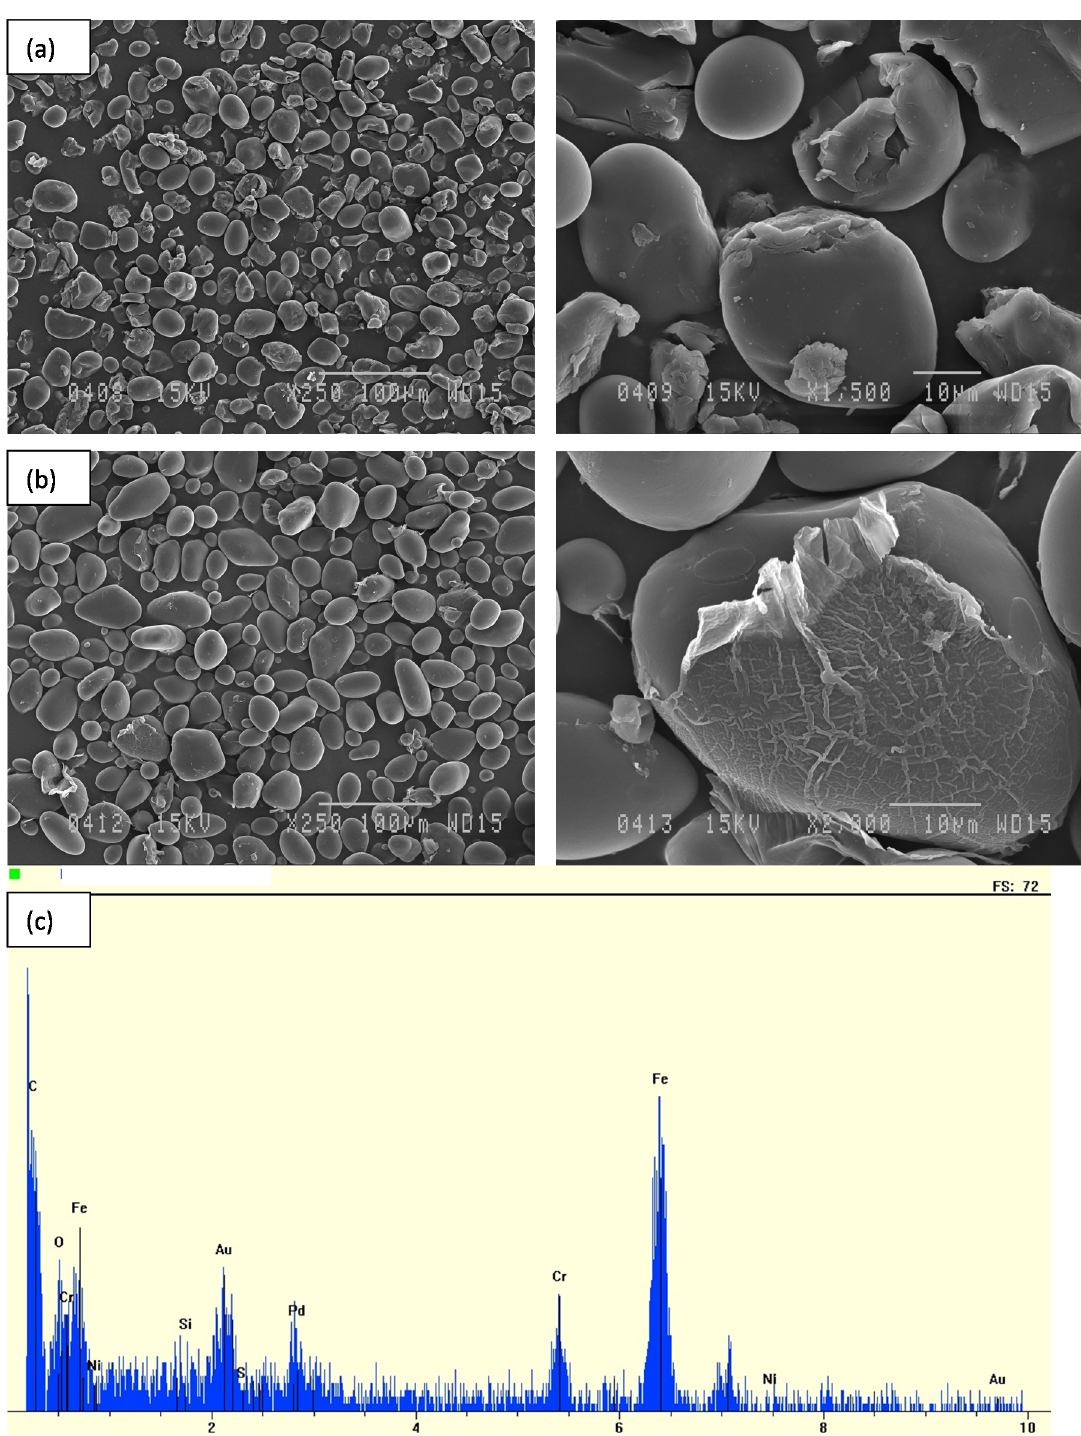
Figure 4. SEM images of potato starch granules treated using HEBM under dry ( a ) and wet ( b ) conditions; energy-dispersive X-ray spectroscopy of potato starch treated using HEBM ( c ). The potato starch granules treated with ultrasonication under dry as well as wet conditions followed by different drying techniques exhibited various morphologies (Figures 5 and